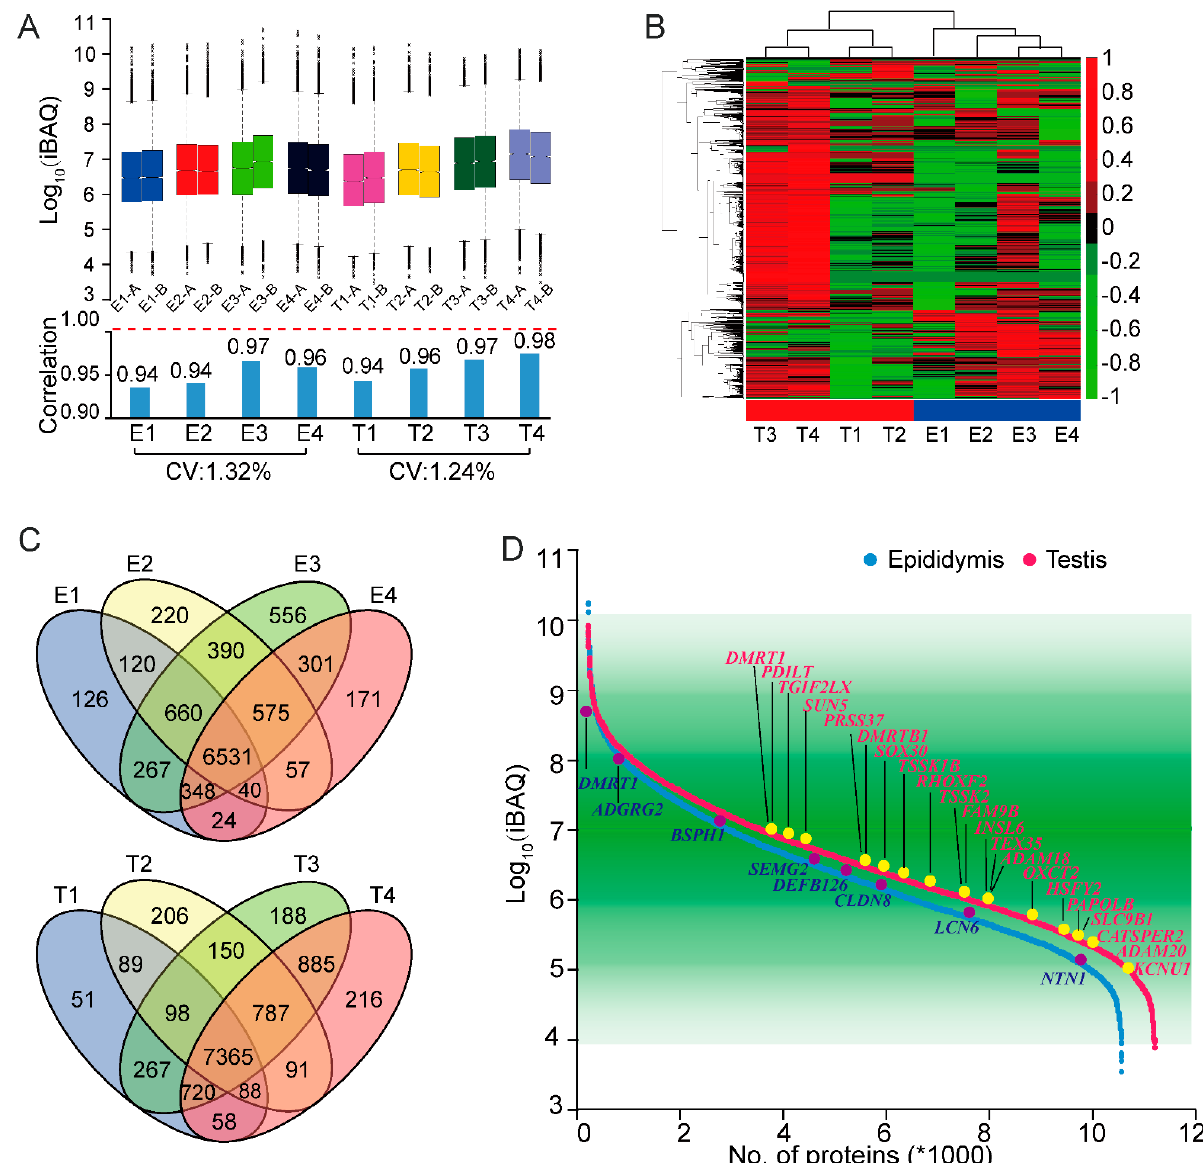
Figure 2. The proteomics analysis of the testis and epididymis. ( A ) Top, boxplot analysis of the sample is illustrated. The sample is presented on the horizontal axis and the normalized amounts of expression are shown on the vertical axis. Bottom, the coefficient of variation of proteins in the two technical repetitions and the same tissues. ( B ) Heat map showing a pairwise correlation between proteins across all individuals, with positive correlation in red and negative correlation in green. ( C ) Venn diagram of proteins identified in testis and epididymis. ( D ) Distribution of protein quantitative value. Proteins are ranked by iBAQ value and the dynamic range of protein level spanned over six orders of magnitude in testis and epididymis. The * means the number multiply by 1000. Several proteins of interest are highlighted in red and blue; a complete list is provided in the dataset.